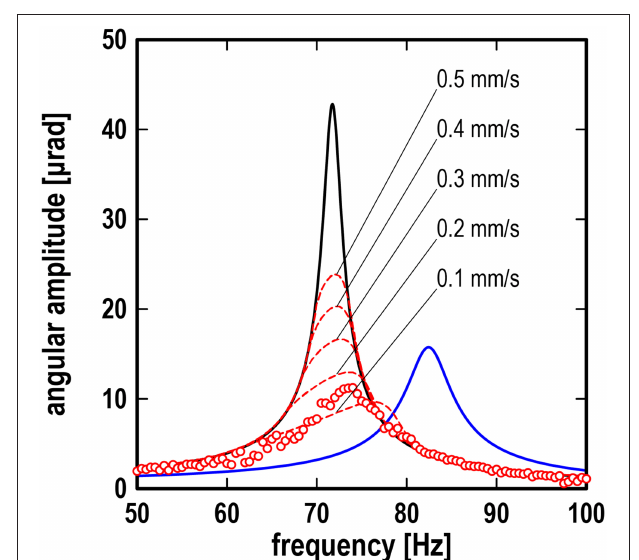
FIGURE 5 | Resonance curves showing frequency response of angular amplitude; black line: theoretical results for case I (no contact) and case III (fully slipping contact); blue line: theoretical result for case II (static contact) at W 20N; the blue line is barely visible due to excellent fitting; black symbols: experimental data at W 0N and V 0 mm/s; blue symbols: experimental = = data at W 20N and V 0 mm/s. = =